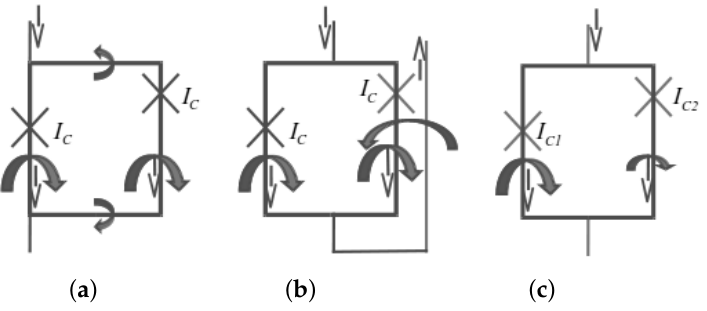
Figure 3. Illustration of the SQUID categories according to symmetry: ( a ) Layout asymmetry in the SQUID loop. ( b ) Layout asymmetry in a bias line. ( c ) Josephson asymmetry (provided I C 1 (cid:54) = I C 2